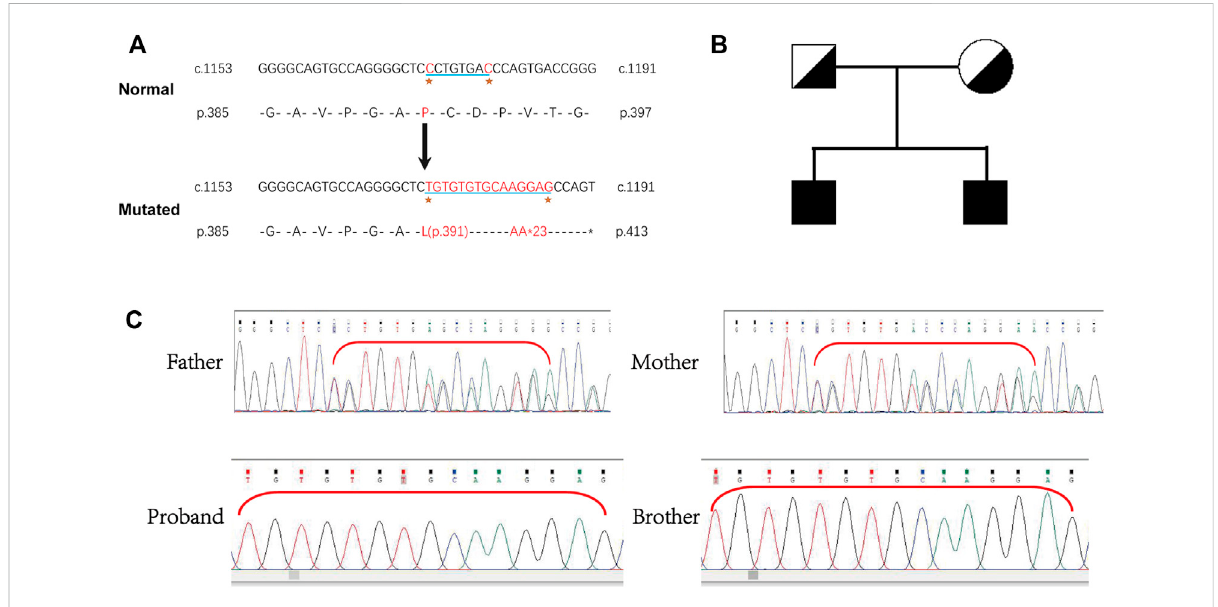
FIGURE 2 (A) Exome sequencing identi fi ed a homozygous mutation, LAMB3 : NM_000228.2: exon11: c.1172_1179delinsTGTGTGTGCAAGGAG: p.P391Lfs*23inthepatient. (B) Pedigreeshowingunaffectedparentsandtwoaffectedbrothers. (C) Homozygosityofthismutationinthepatientand his older brother was con fi rmed by Sanger sequencing, and the clinically unaffected parents were heterozygous